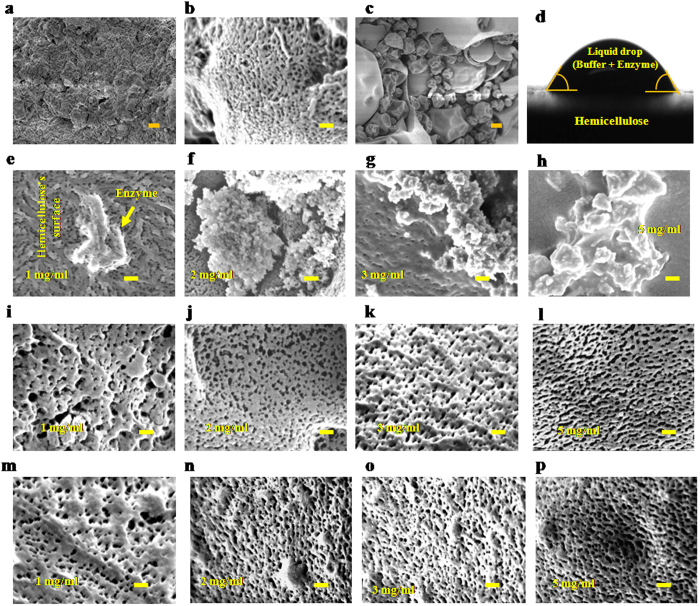
Surface morphology and contact angle.(a–c,e–p) FESEM images. (a) Beechwood xylan. (b) Pores on the surface of beechwood xylan. (c) Endoxylanase. (d) Contact angles between liquid and hemicellulose’s surface measured by Goniometer (ram´e-hart Germany) are 39.9 ° (left) and 40.6 ° (right). (e–h) Adsorbed enzyme on the solid hemicellulose at 4 h and E0/Cs = 0.1. (i–l) Pores structure on the surface of solid residue obtained from the enzymatic hydrolysis of xylan at 40 °C and at 1 h. (m–p) Pores structure on the solid surface at 5 h. In (i–p) the solid residues are more porous than in (b) due to the rapid pore-scale dissolution of the solid. Scale bars: (a,c) 1 μm; (b,e–p) 100 nm.